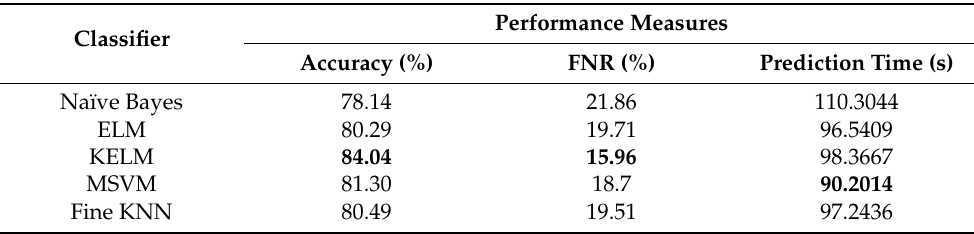
Table 9. Multiple skin lesion type classification results using optimal DenseNet201 deep features. Best values are shown in bold.